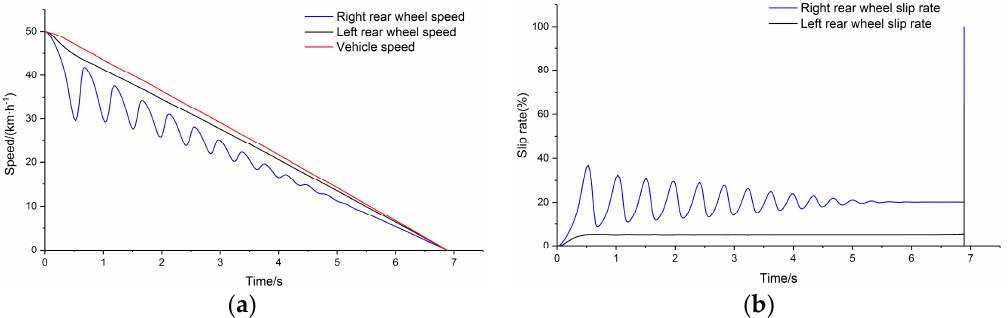
Figure 12. ( a ) Comparison of main drum speed and wheel speed; ( b ) slip rate.